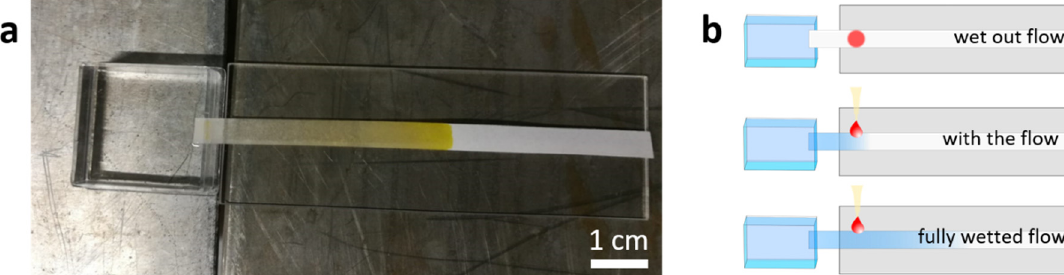
Figure 6. ( a ) Flow experiment with BSA-FITC as the analyte. The paper strip is placed on a PMMA backing and dipped into